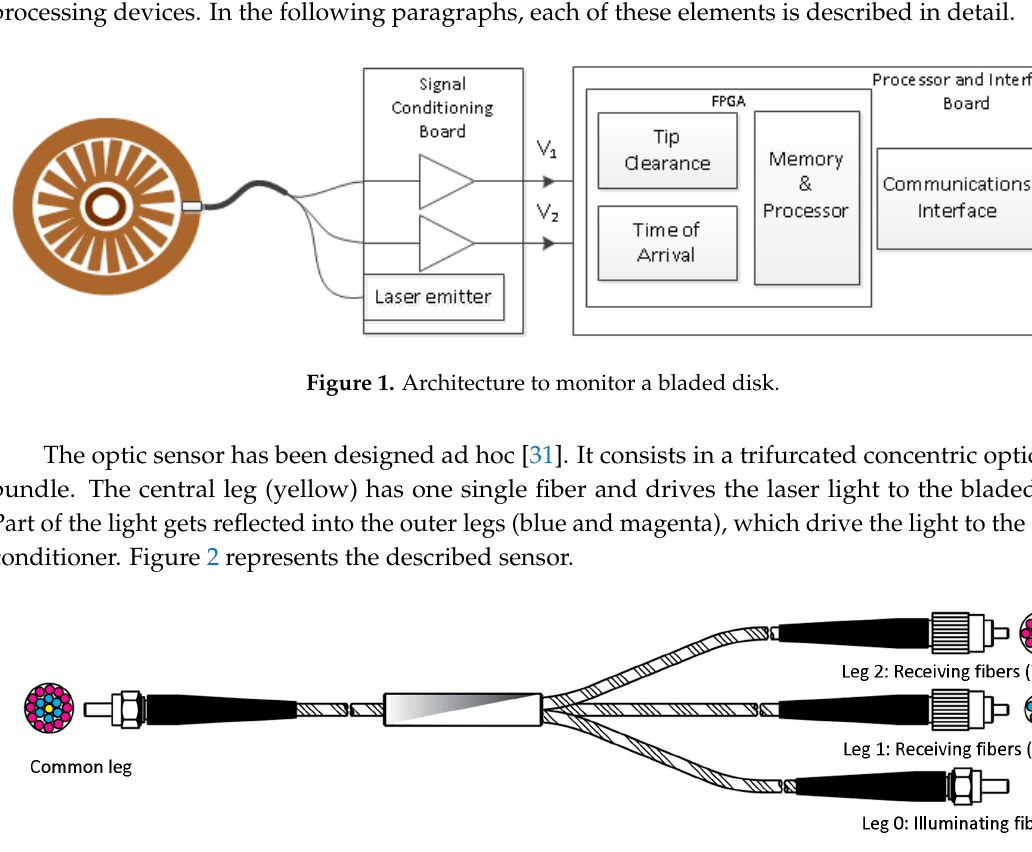
Figure 2. Trifurcated optic sensor.